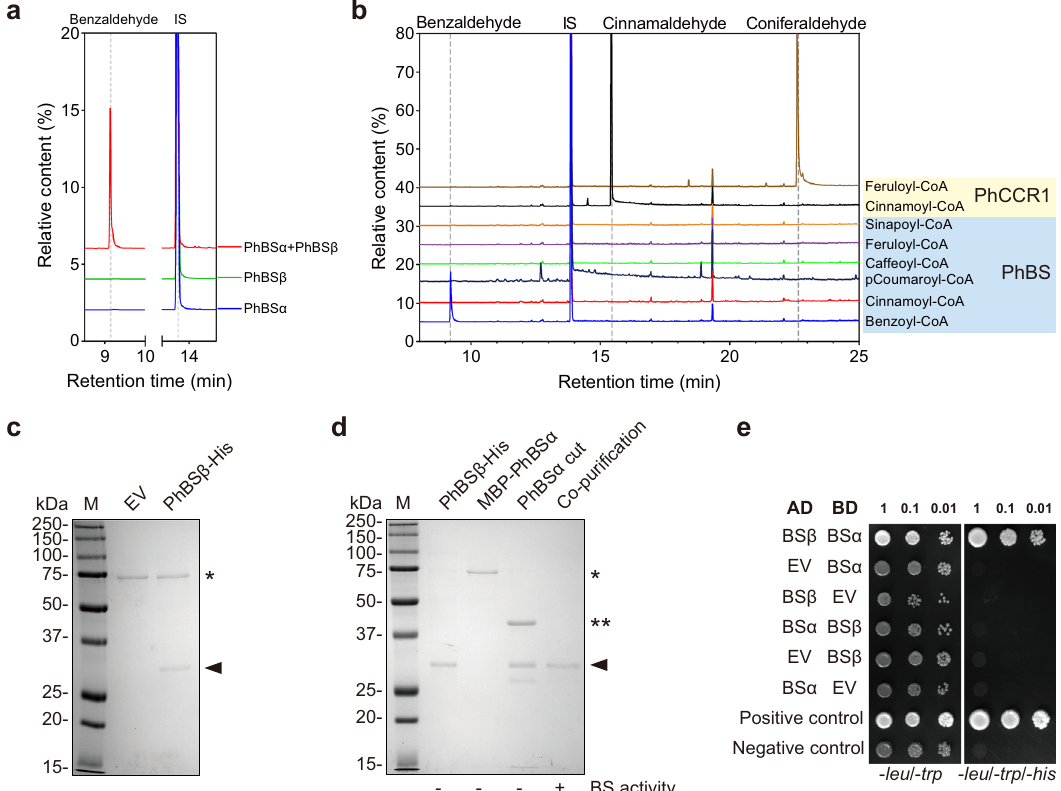
Fig. 4 Heterodimeric nature and substrate speci fi city of PhBS. a GC – MS analysis of products formed by PhBS α and PhBS β subunits, and their mixture at 1:1 ratio. The response of internal standard in each run was set as 100%. b GC – MS analysis of products formed by PhBS from different hydroxycinnamoyl- CoA substrates. GC-MS chromatograms of in vitro enzymatic assays using various substrates. Puri fi ed PhBS (1:1 ratio between α and β subunits) was incubated with benzoyl-CoA and its structural analogs including cinnamoyl-CoA, para -coumaroyl-CoA, caffeoyl-CoA, feruloyl-CoA, and sinapoyl-CoA. Formation of cinnamaldehyde and coniferaldehyde by puri fi ed PhCCR1 was used as a positive control. Shown are combined EICs of mass units 106 (benzaldehyde), 128 (internal standard), 131 (cinnamaldehyde), and 178 (coniferaldehyde). The response of internal standard in each run was set as 100%. IS, internal standard. c Pull-down analysis of PhBS β -His binding to MBP-PhBS α . Puri fi ed MBP-PhBS α was incubated with bacterial lysate of pET32b empty vector (EV) or pET32b expressing PhBS β -His, protein complex was puri fi ed using Amylose resin and analyzed by SDS – PAGE. (*) indicates the position of MBP-PhBS α ; triangle indicates the position of PhBS β -His. The experiment was repeated three times with similar results. d Pull-down analysis of PhBS α binding to PhBS β -His. Puri fi ed MBP-PhBS α was digested with Factor Xa protease, incubated with puri fi ed PhBS β -His, the complex was puri fi ed again using Ni-NTA column and analyzed by SDS-PAGE. (*) indicates the position of MBP-PhBS α ; (**) indicates the position of free MBP tag; triangle represents the position of PhBS β -His and untagged PhBS α , as indicated by BS activity. The experiment was repeated three times with similar results. e Y2H detection of PhBS α and PhBS β interactions. Yeast cells harboring different combination of AD and BD were spotted at increasing dilutions on nonselective (- leu /- trp ) and selective medium (- leu /- trp /- his ). AD, activation domain of pGAD-T7 and BD, DNA-binding domain of pGBK-T7, to which petunia BS α and BS β were fused; EV empty vector. At least 10 colonies from each combination were tested on selective medium with same results.